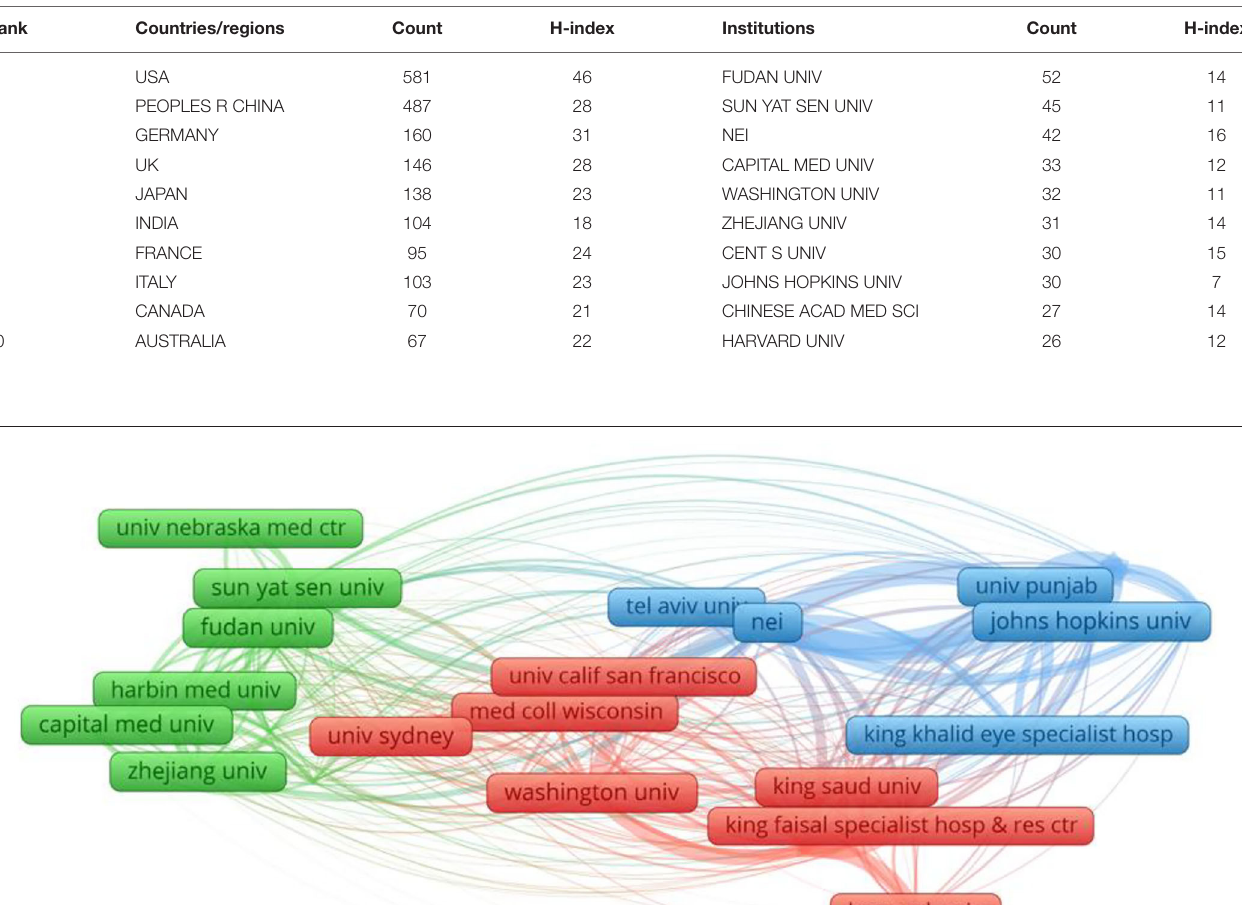
the right side, and the colored paths indicate the citation relationships. The color paths indicated that studies,